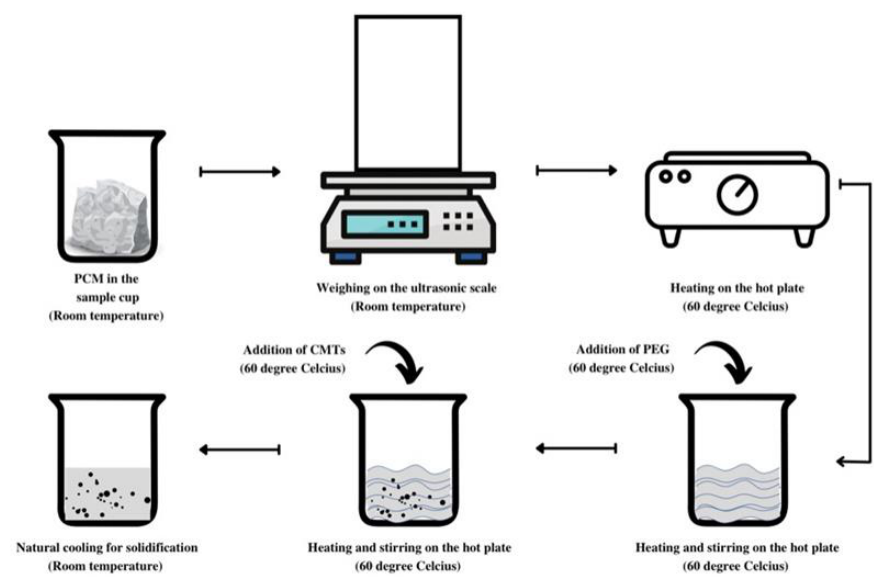
Figure 2. A schematic diagram for the preparation of macro-enhanced PCM.